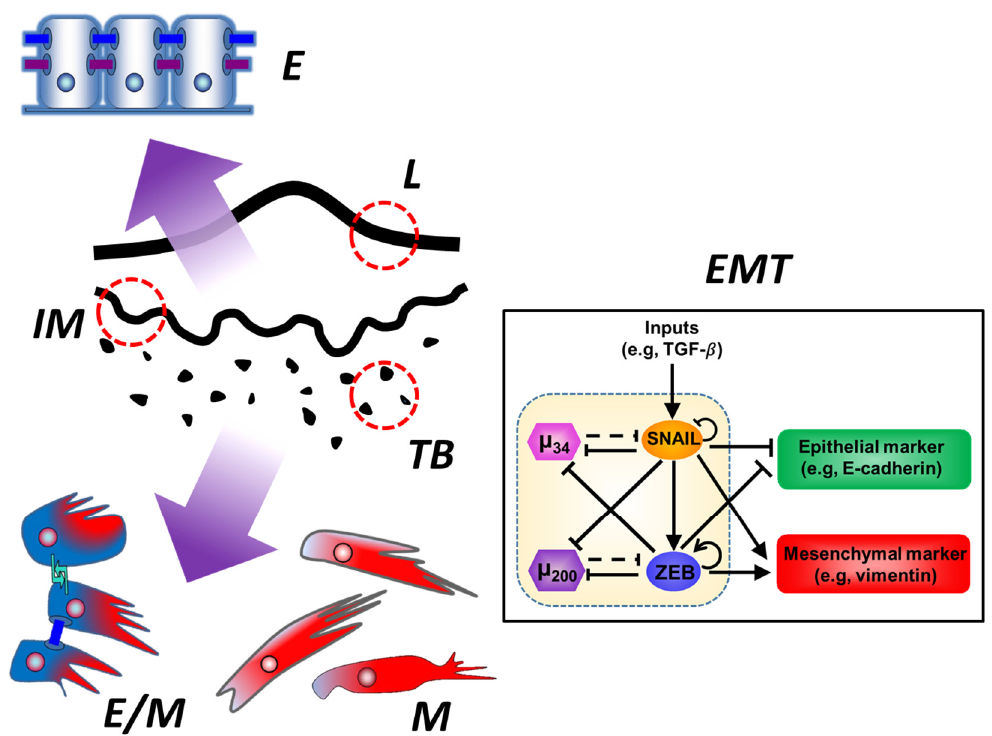
Figure 1. Tumor budding as a partial epithelial-mesenchymal transition. (Left) Tumor budding (TB) occurs mainly at the invasive tumoral margin (IM) which is opposite to the luminal margin (L). Studies have shown that tumor buds as a whole show a loss of epithelial markers and a gain of mesenchymal markers as compared to the main tumor mass. These features are compatible with epithelial-mesenchymal transition, which is why budding is considered to be the histological expression of the same. However, not all the cells in a tumor bud are purely mesenchymal, so budding rather mirrors a partial epithelial-mesenchymal transition. While the main tumor mass is most notably composed of purely epithelial (E) cells, the tumor buds are greatly enriched in purely mesenchymal (M) and even hybrid epithelial-mesenchymal (E/M) cells. (Inset) Epithelial-mesenchymal transition (EMT) is controlled by a core regulatory circuit composed of four players: two microRNAs, known as miR-34 ( µ 34 , pink hexagon) and miR-200 ( µ 200 , purple hexagon), respectively, and two transcription factors, referred to as SNAIL (orange ellipse) and ZEB1/2, which stands for Zinc finger E-box-binding homeobox-1 or -2 (ZEB, blue ellipse), respectively. The microRNAs promote the epithelial phenotype, characterized by synthesis of epithelial markers such as E-cadherin (green rounded rectangle). The transcription factors promote the mesenchymal phenotype, characterized by the synthesis of mesenchymal markers such as vimentin (red rounded rectangle). The core EMT regulatory circuit consists of two mutually inhibitory feedback loops, miR-34/SNAIL and miR-200/ZEB, respectively. Solid arrows depict transcriptional activation, with circled arrows showing self-activation. Solid bar-headed arrows depict transcriptional inhibition, with circled bar-headed arrows showing self-inhibition. Dotted bar-headed arrows represent microRNA-mediated regulation at a translational level. The relative concentrations of the four players at any given time point alter the resultant state of the core EMT regulatory circuit, thus altering the expression of epithelial and mesenchymal genes and consequently the synthesis of epithelial and mesenchymal markers. By this mechanism, the core EMT regulatory circuit governs the cellular phenotype, which can exist in (or dynamically switch between) a purely epithelial (E), a hybrid epithelial/mesenchymal (E/M), and a purely mesenchymal (M) phenotypic state. See text for more details on the relationship between EMT at a molecular scale and tumor budding at a histologic scale.